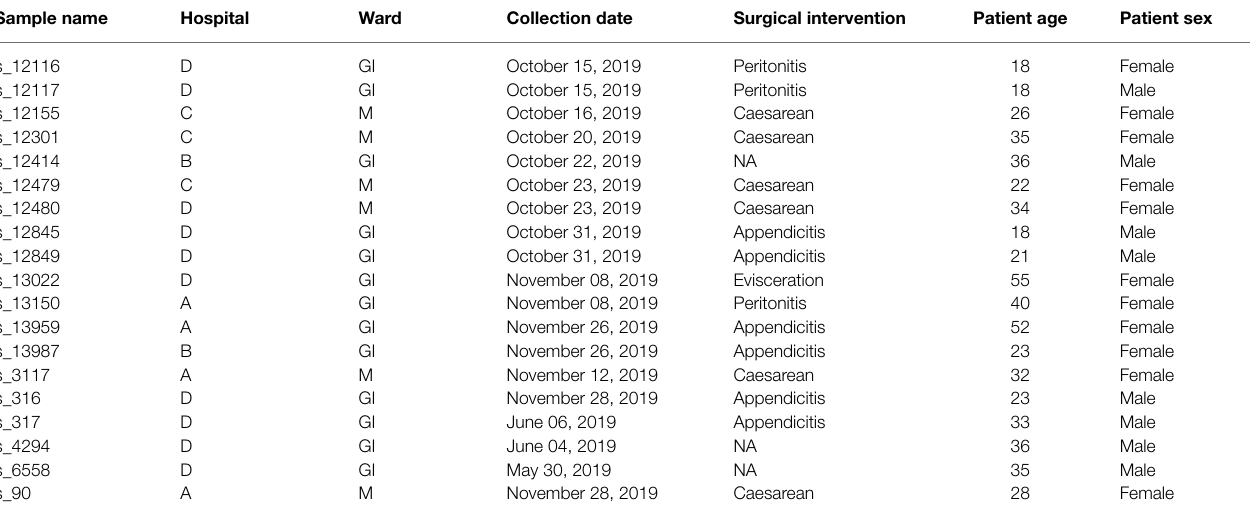
TABLE 1 | Overview of the 19 samples sequenced in this